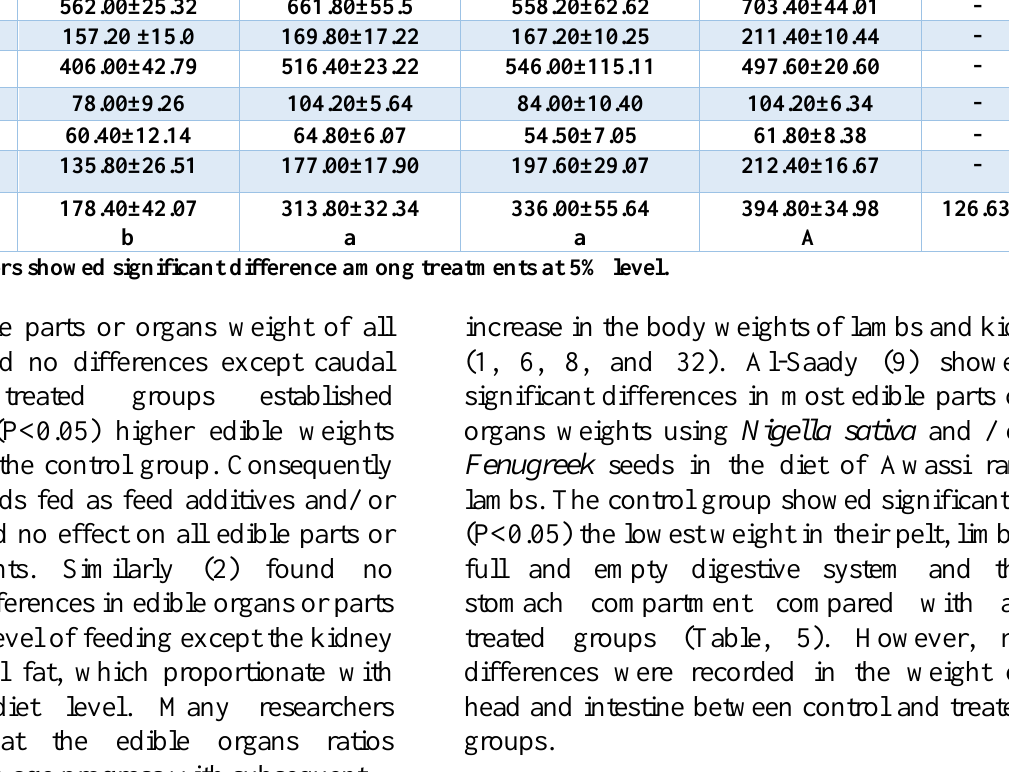
Table, 5: Effects of vasectomy and/or adding Cuminum cyminum in the diet on the weights of inedible parts or organs (Kg) of Awassi male lambs (Mean±SE).